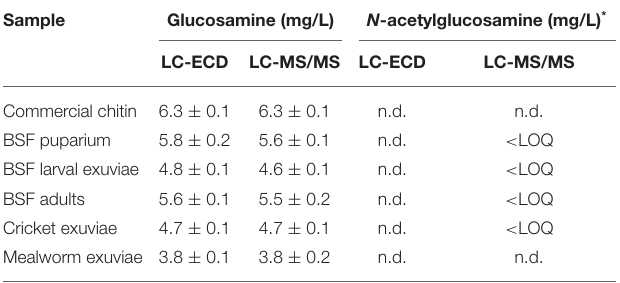
TABLE 4 | Concentrations (mg/L) of glucosamine and N -acetylglucosamine in hydrolyzed commercial chitin and chitin extracts of different insect exuviae as measured by LC-ECD and LC-MS/MS.